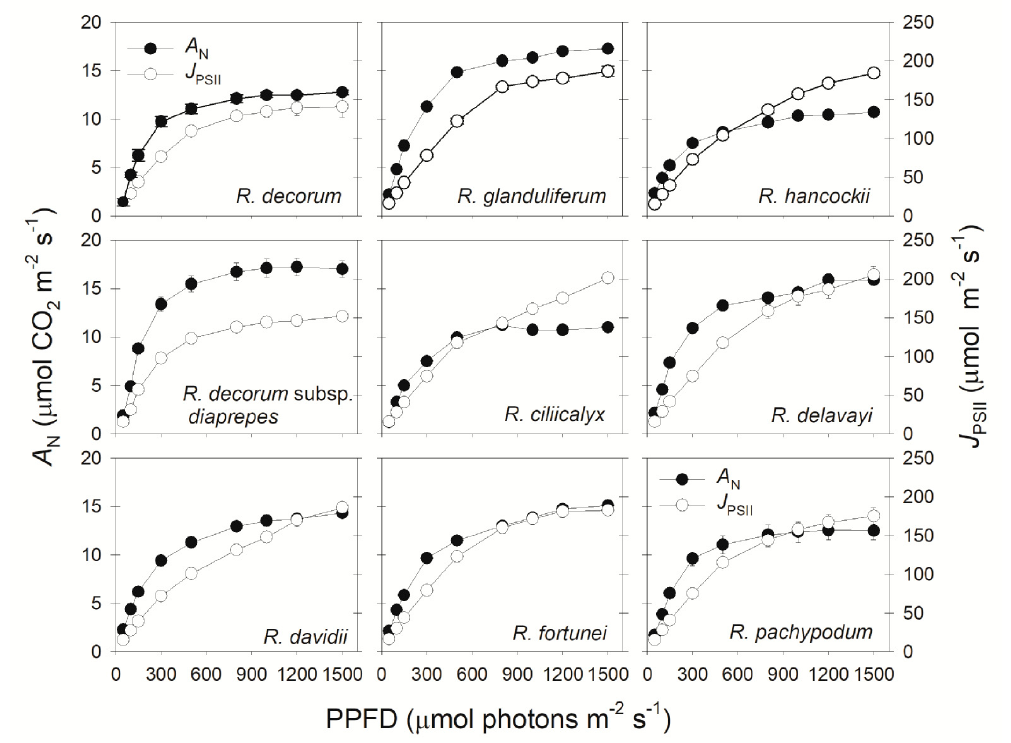
Figure 1. Responses of the leaf CO 2 assimilation rate ( A N ) and electron transport rate ( J PSII ) to incident photosynthetic photon flux density (PPFD) in nine Rhododendron species. Symbols represent means ± SE ( n = 4–5).